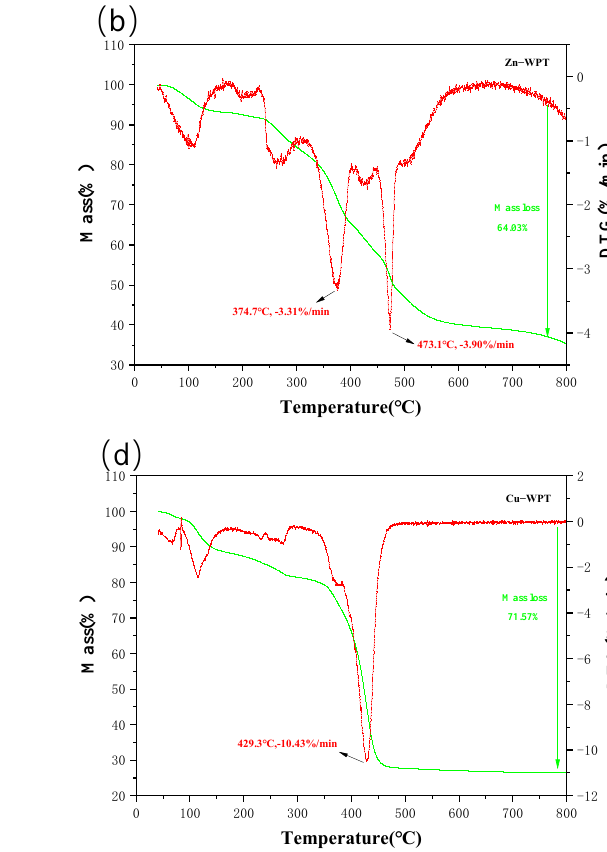
Figure 1. The TG − DTG curves of the four samples: −−− ( a ) WPT; ( b ) Zn − WPT; ( c ) Fe − WPT; ( d ) Cu − WPT. According to Figure 1c, the pyrolysis process of Fe − WPT included three stages. In the first stage (40~170 ◦ C), corresponding to the decomposition of FeCl 3 into FeOOH and HCl (g), HCl (g) could catalyze the pore formation process [27], and the mass loss in this stage was about 16.2%. In the second stage (170~500 ◦ C), an obvious peak could be observed at about 260 ◦ C in the DTG curve, which was due to the iron salts undergoing decomposition and reduction reactions to form iron oxides [29]. Then, the main components of Fe − WPT decomposed rapidly, and a peak appeared in the DTG curve at 422 ◦ C, which was lower than the peak of WPT but higher than that of Zn − WPT, with the mass loss of about 31.6% in the whole stage. The mass loss in the third stage (500~800 ◦ C) was about 13.5%, which was mainly caused by the consumption of carbon with Fe 2 O 3 and Fe 3 O 4 through the reduction reaction, and the reaction between Fe and amorphous carbon generated Fe 3 C [30].